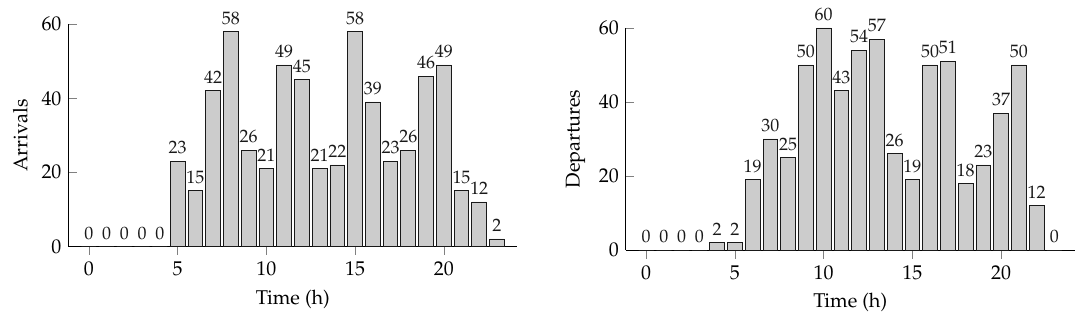
Figure 8. Flight operations at Frankfurt Airport on 17 November 2017.